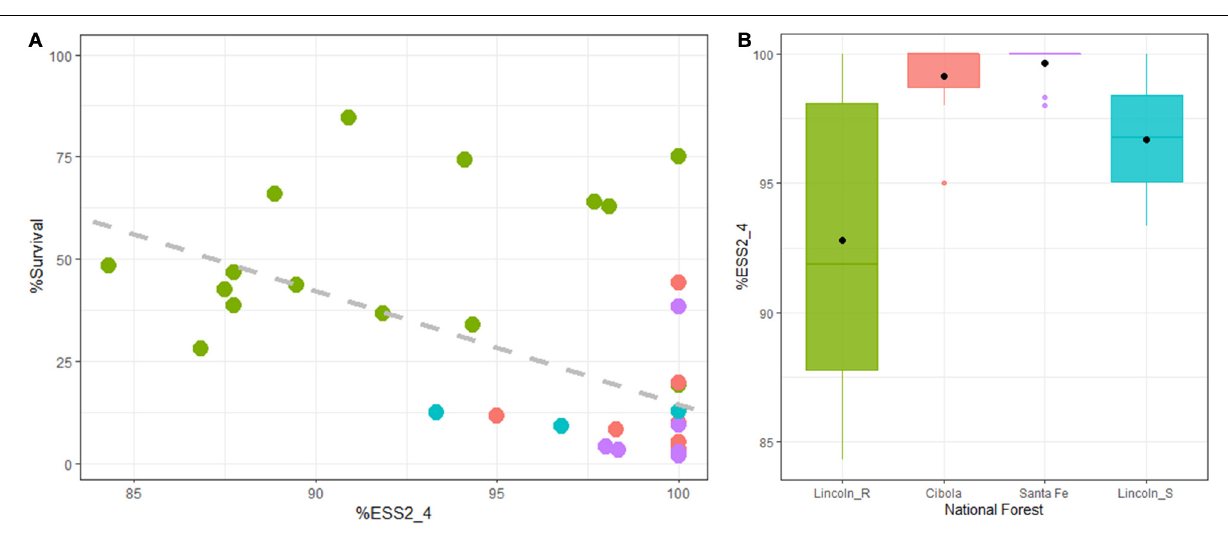
FIGURE 3 | %ESS 2_4 : (A) There is a significant and negative relationship between the %Survival and %ESS 2_4 ( y = 291.99 × –2.78, P < 0.001, r = 0.532). (B) Most families in the Cibola (pink) and Santa Fe (purple) National Forests had 100% stem symptom development at 1.42 years post-inoculation (2nd assessment). Both Lincoln R (green) and Lincoln S (blue) had a lower %Early Stem Symptom development suggesting a level of